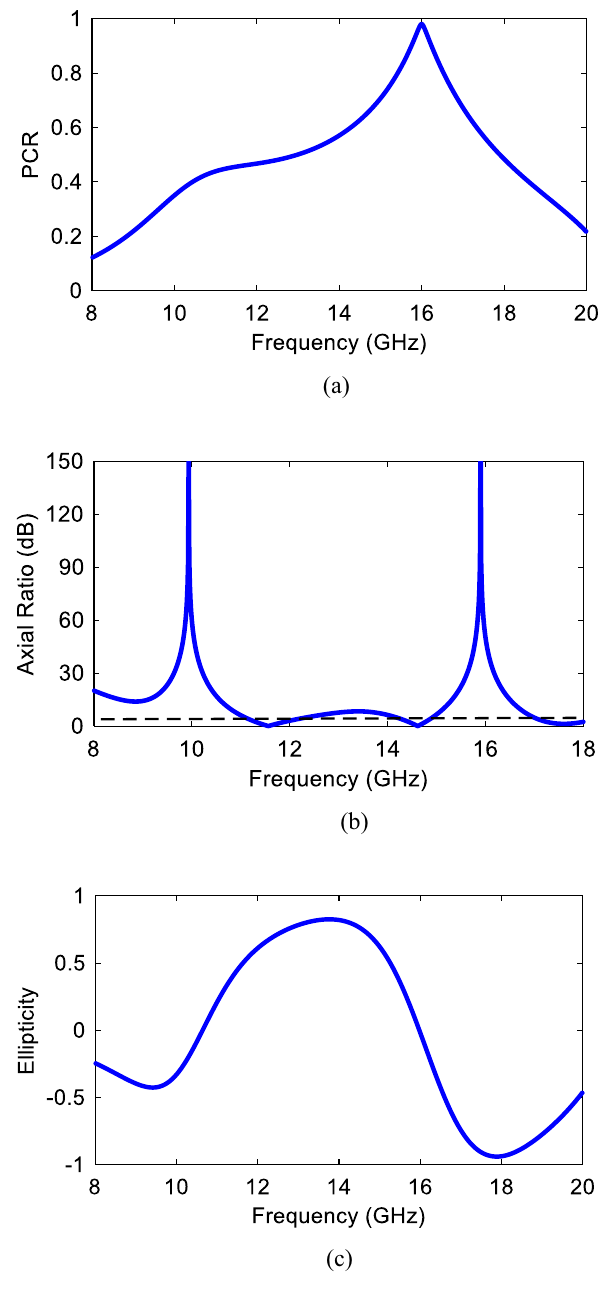
Figure 3. ( a ) Polarization converter ratio, ( b ) axial ratio, ( c )